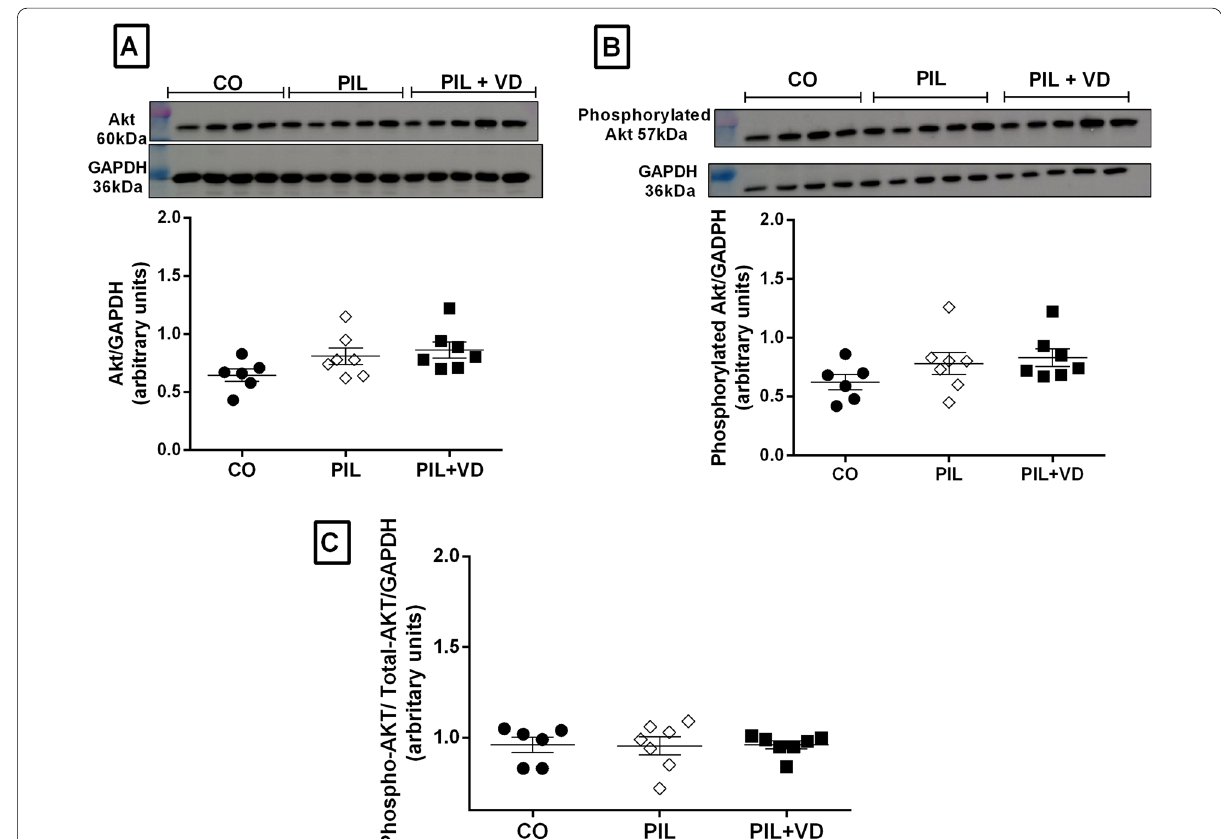
Fig. 6 Protein expression of synthesi markers in gastrocnemius muscle. Expression of ( a ) Akt, ( b ) phosphorylated Akt and ( c ) phosphorylated Akt/ akt total ratio in CO, PIL and PIL VD groups. Data in ( a ) and ( b ) represent mean + * p <